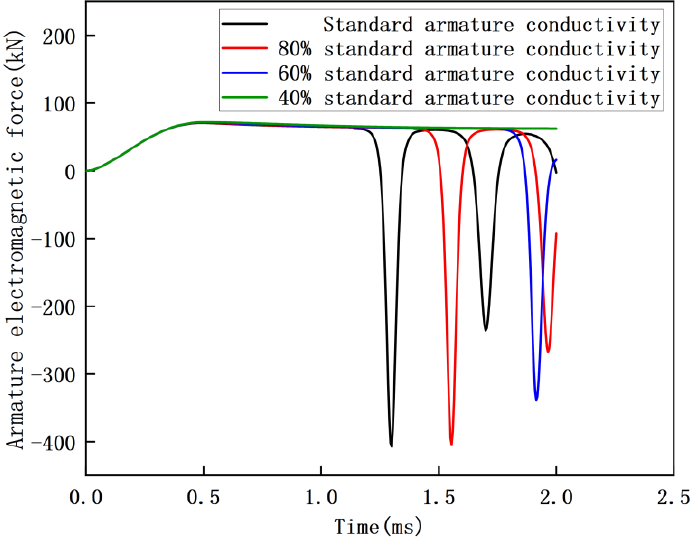
Figure 7. Armature electromagnetic force calculations when only the armature conductivity changes.